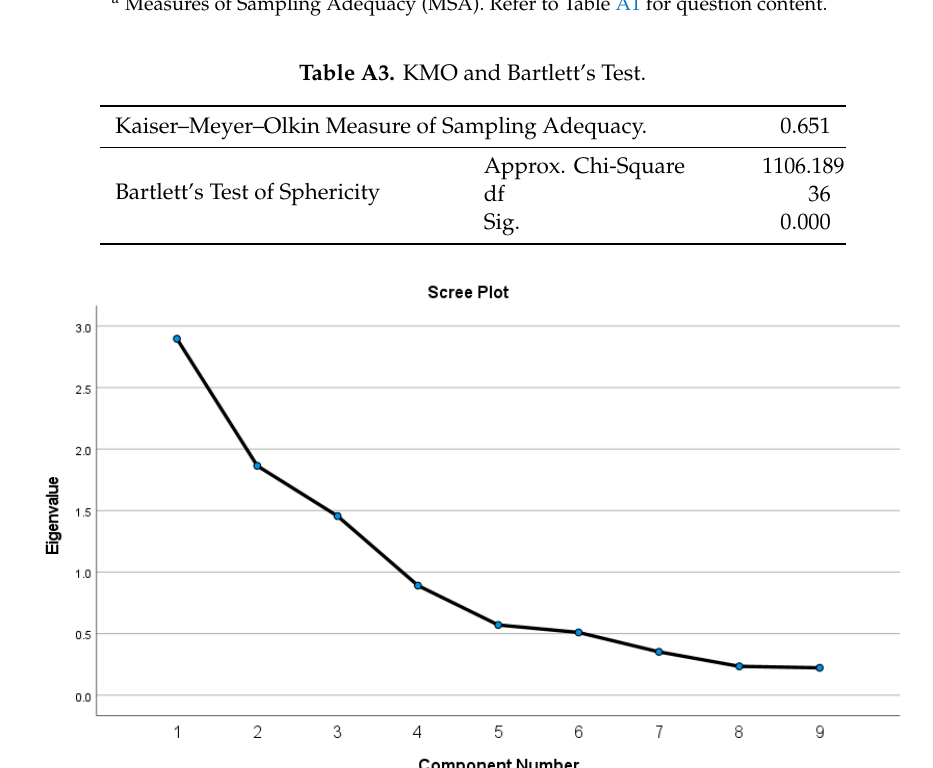
Figure A1. Scree Figure A1. Scree Plot Table A4. Communalities.